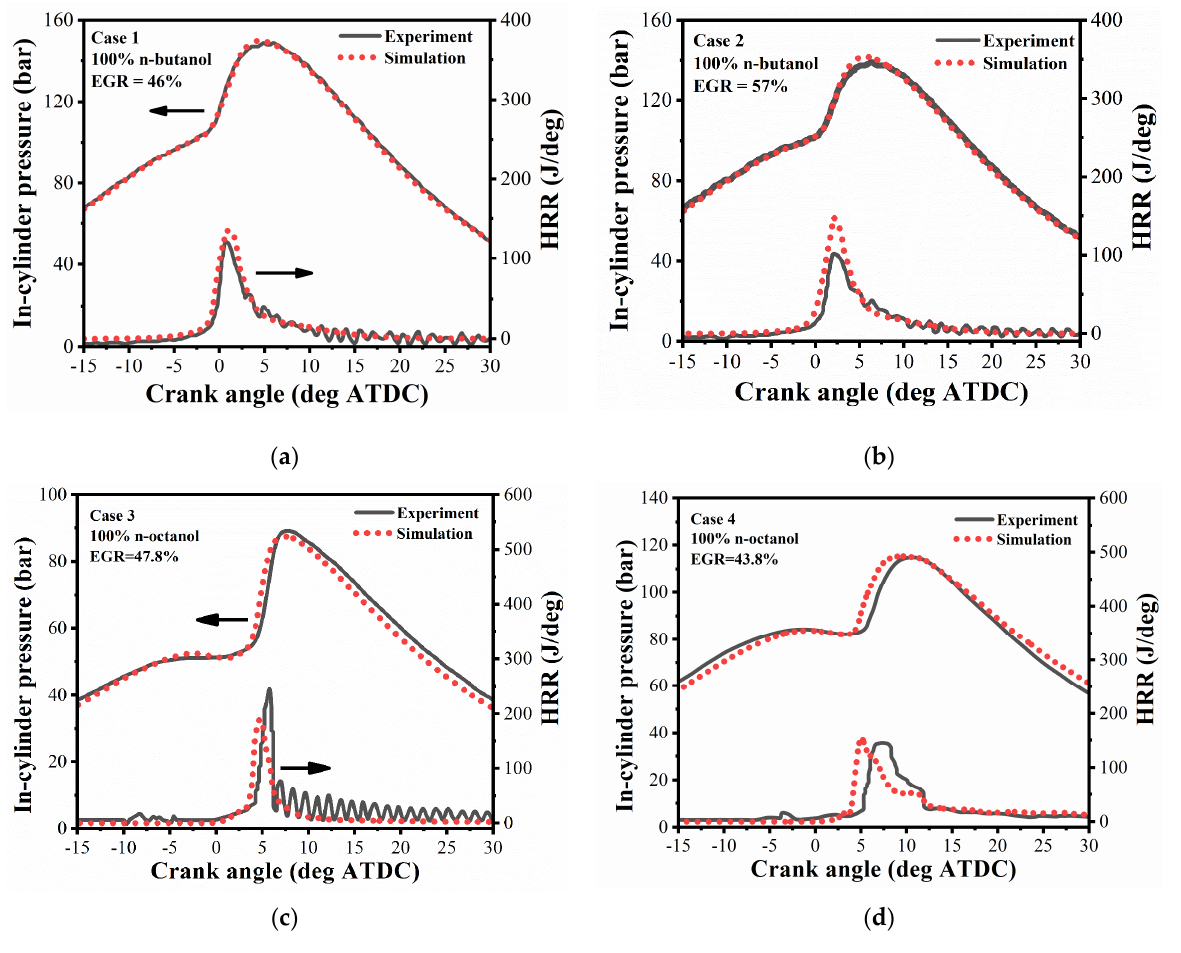
Figure 2. Validation in-cylinder pressure and HRR of HCCI and CCI engines: ( a ) Case 1, ( b ) Case 2, ( c ) Case 3, ( d ) Case 4.